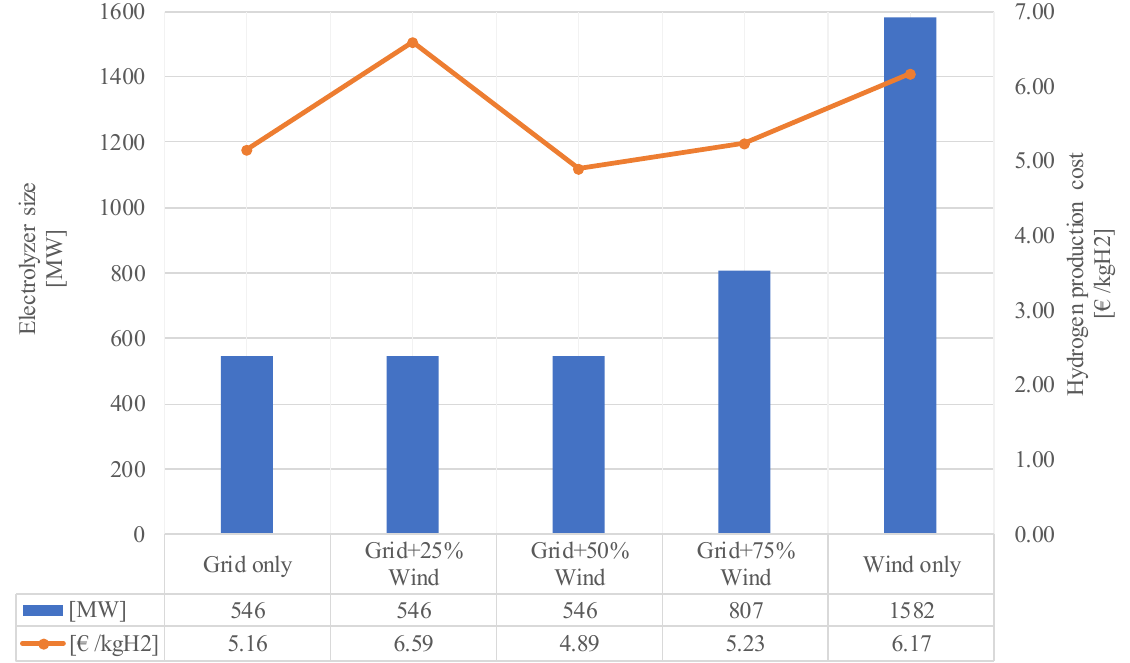
Figure 4. Hydrogen production cost (orange line) in comparison to the electrolyzer size required to meet peak demand (blue bar) based on the results of study cases in [9].